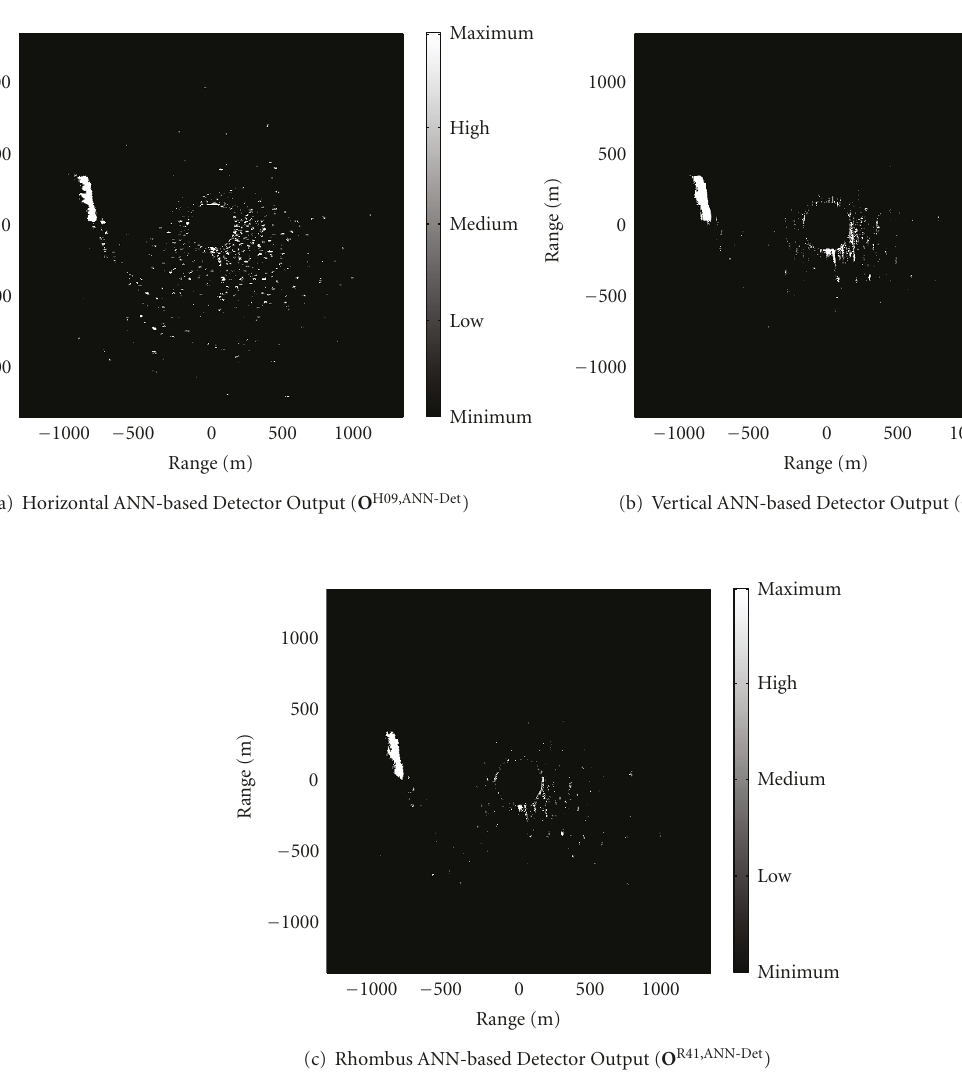
respect to changes in the radar environmental conditions